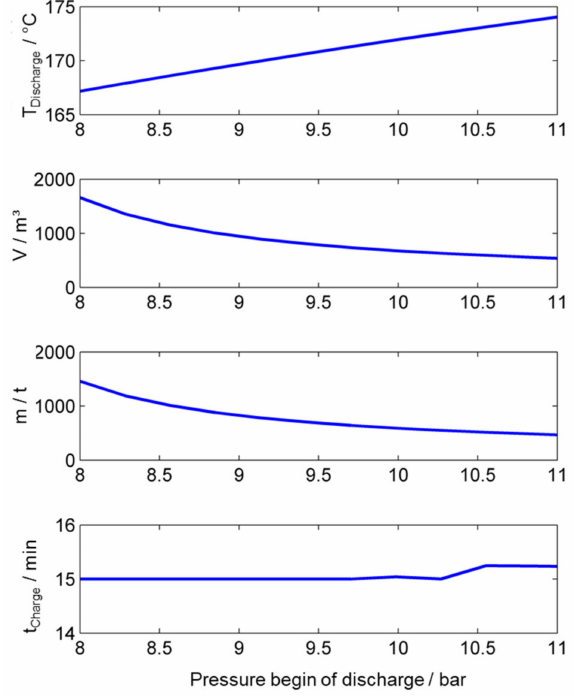
Figure 13. Storage tank temperature, volume, mass as a function of discharge pressure.